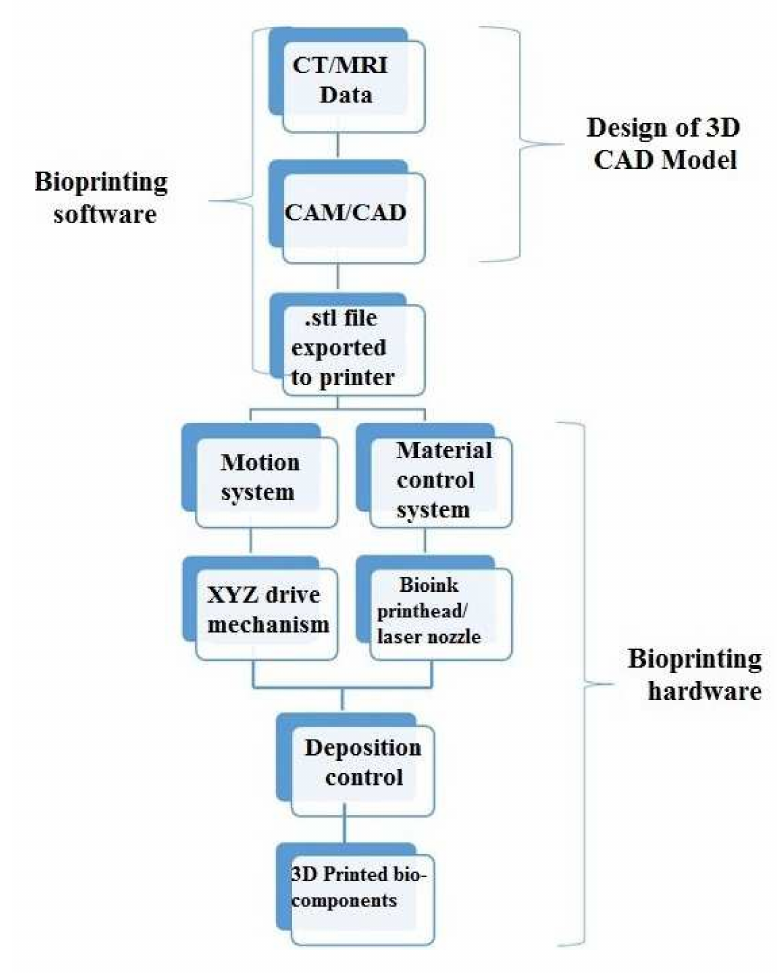
Figure 11. A technical route for 3D bioprinting